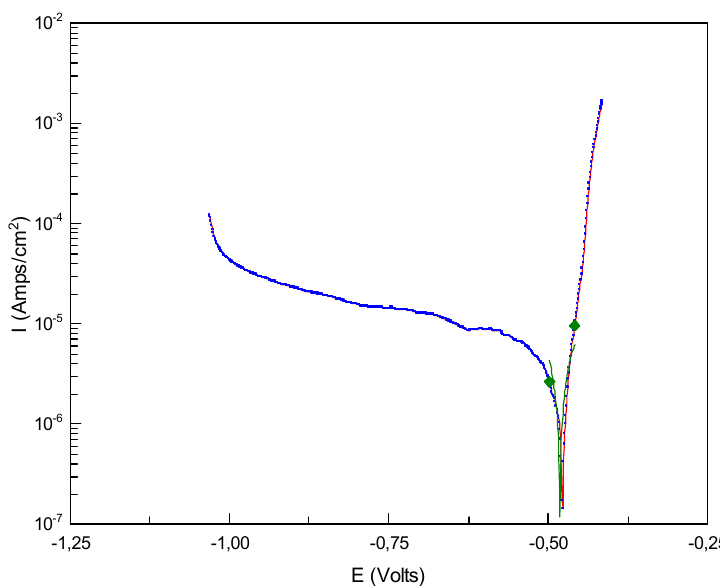
Figure 6. Polarization curve determined for the L30GS steel in 3.5% NaCl solution.